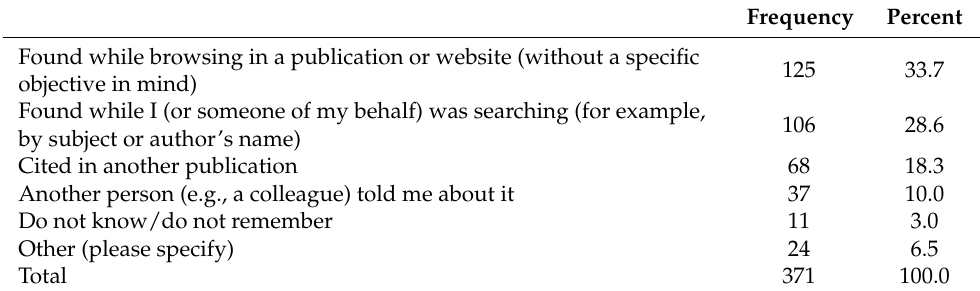
Table 12. How respondents became aware of their last article